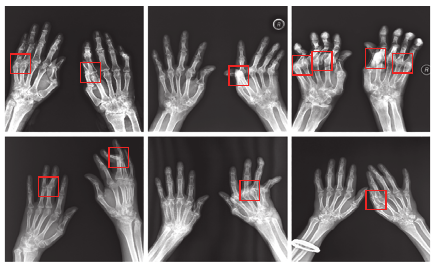
Figure 1: X-rays of some patients with severe RA. Specific posi- tions marked with red ROIs in these images are difficult to